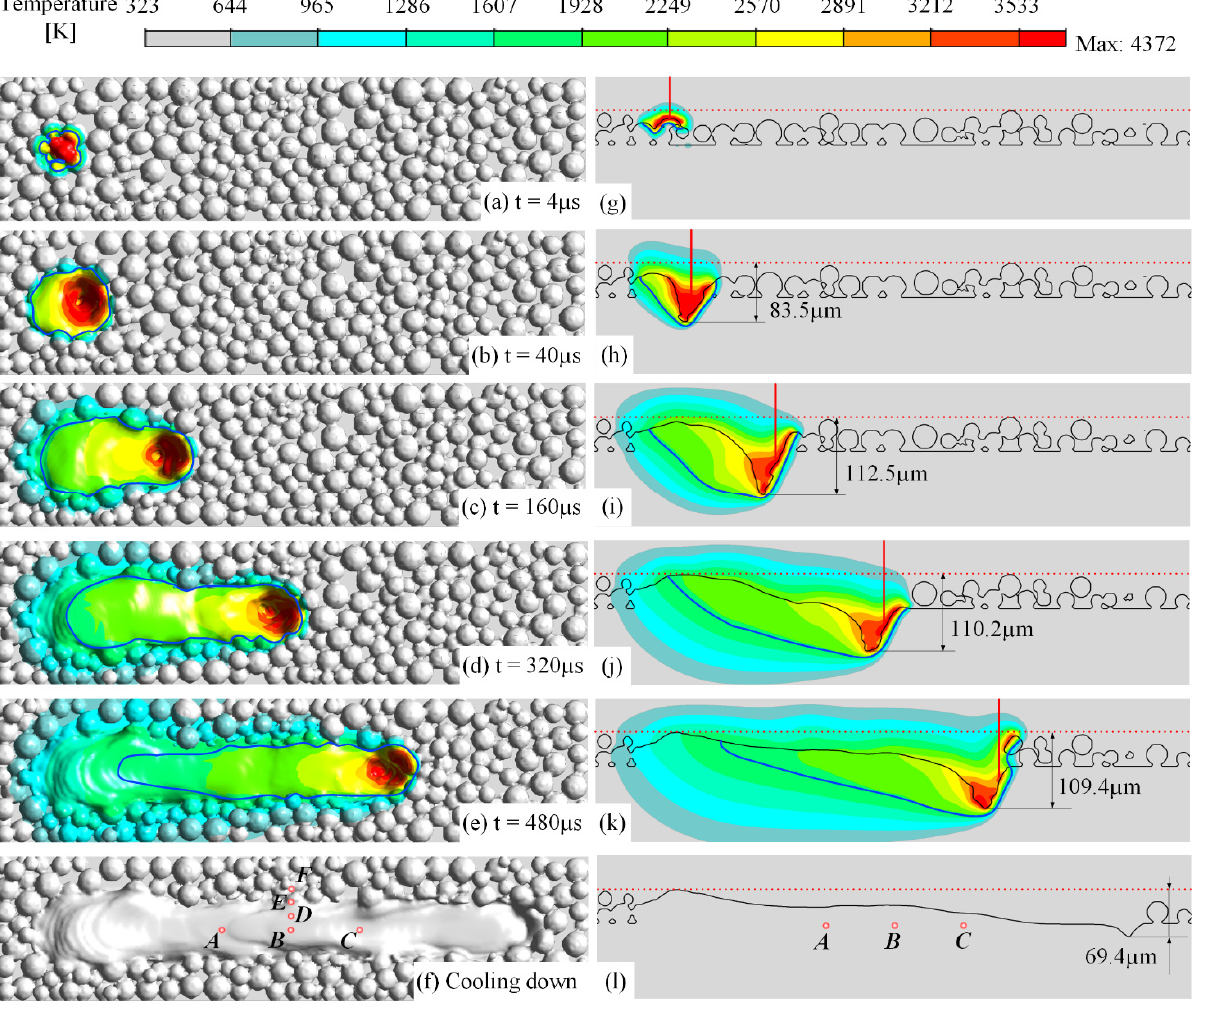
Figure 2. The laser-scanning process on the first layer, where the laser power is 200 W, absorptivity coefficient 0.4, scanning speed 1 m/s, and layer thickness 50 μ m: ( a – e ) the morphology of the track and the temperature field on its surface; ( g – k ) the same on the longitudinal section of the powder bed, in which the red vertical line represents the central line of the laser beam, the red dashed line represents the top tangential surface of the initial powder bed, and the blue line represents the boundary of the molten pool; ( f , l ) the morphology of the solidified track and the same on the longitudinal section, in which 6 points (A–F) are marked to record the temperature history.